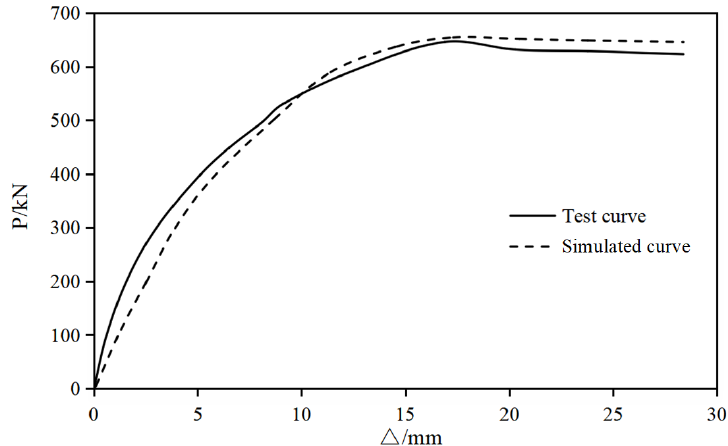
Figure 4. Skeleton curve of test and simulation.